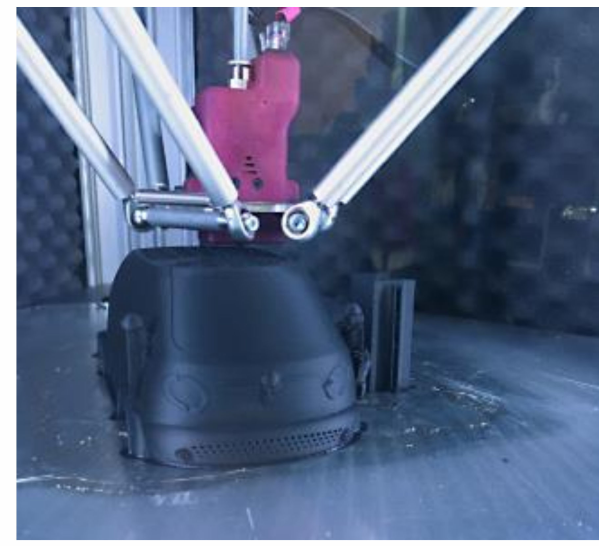
Figure 36. New FIAT 600 Omega—3D